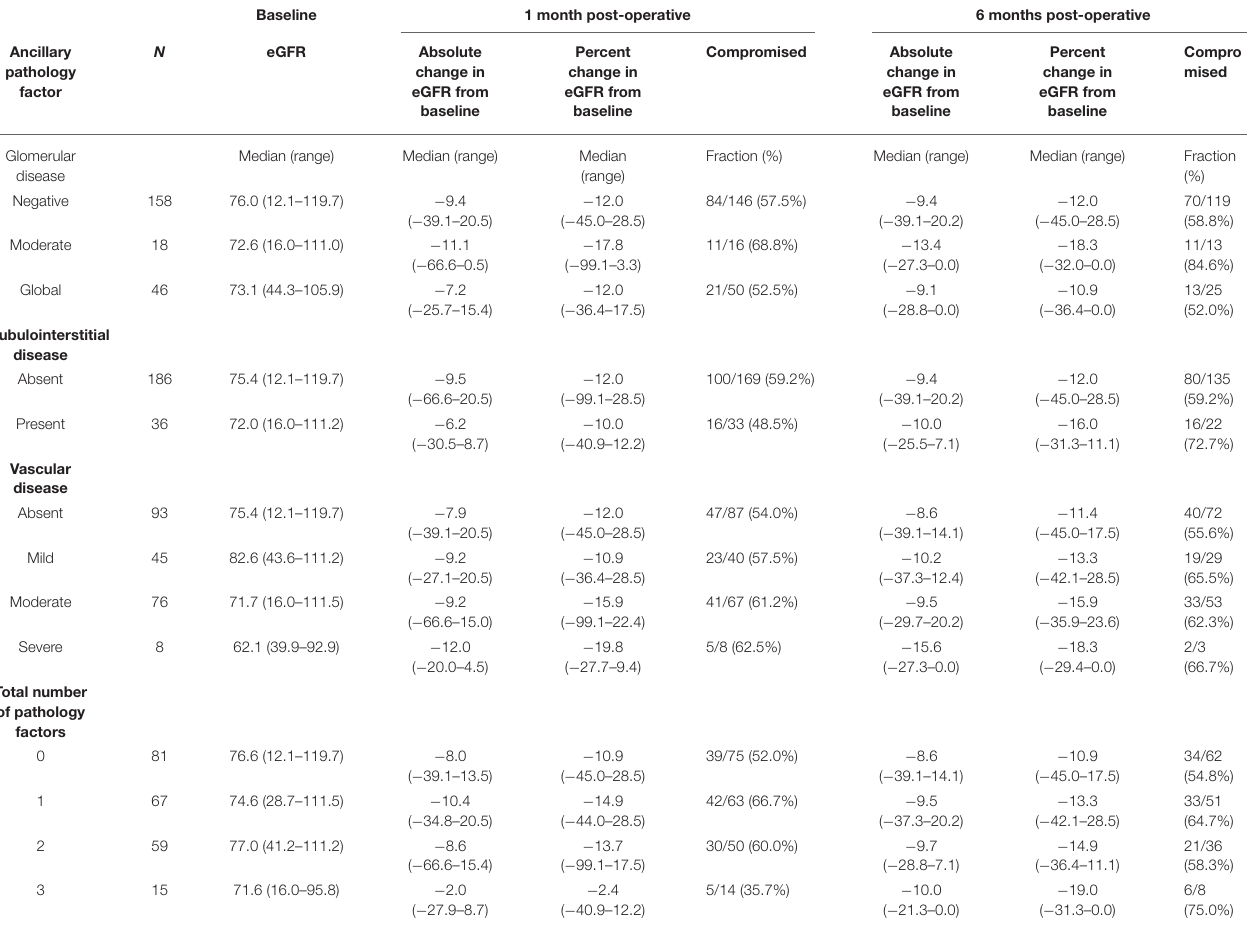
TABLE 3 | Ancillary pathology factors and kidney function before and after robotic assisted partial nephrectomy. Baseline 1 month post-operative 6 months